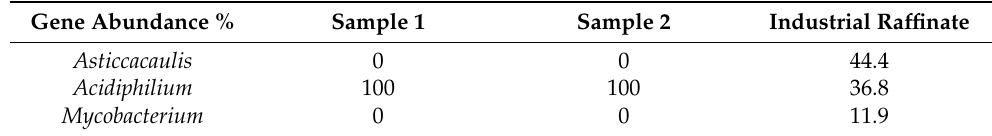
Table 2. Percentage of relative abundances of microorganisms in each sample. Gene Abundance % Sample 1 Sample